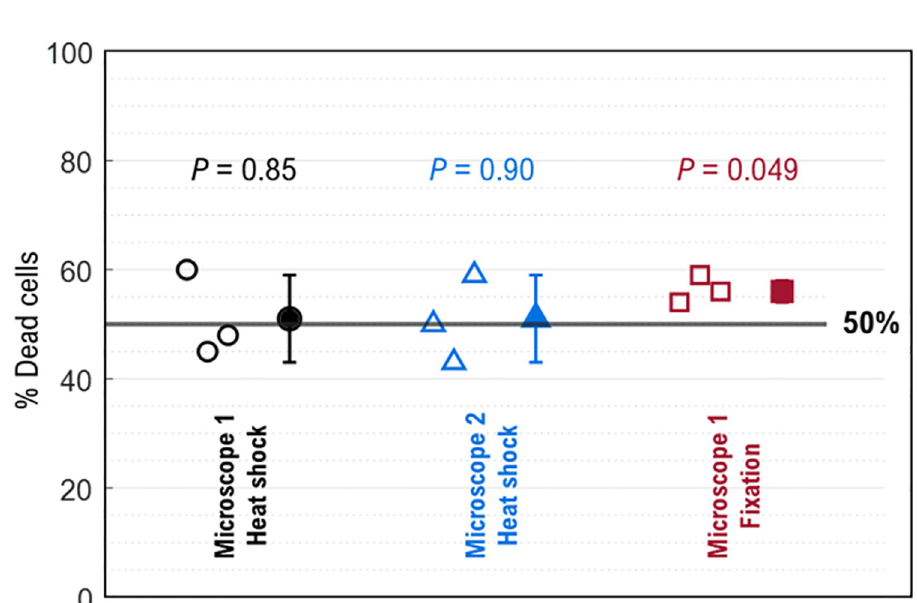
Fig 8. Percent dead cells of three different experimental conditions of ‘Live and dead cells in TB’ experiment. Open symbols indicate triplicate experiments (same sample preparation, data acquired on three different days) of heat- shock treatment using Microscope 1 (black circles), heat-shock treatment using Microscope 2 (blue triangles), and fixation treatment using Microscope 1 (red squares). Microscope 1: Biotek Lionheart FX, Microscope 2: Nikon Ti2. The filled symbols represent the mean of three replicates and the corresponding error bars indicate standard deviation. Above the data are P -values from a one-sample t-test (two-tailed) where a low P -value indicates an increased probability that the sample mean is different from the 50% hypothesized